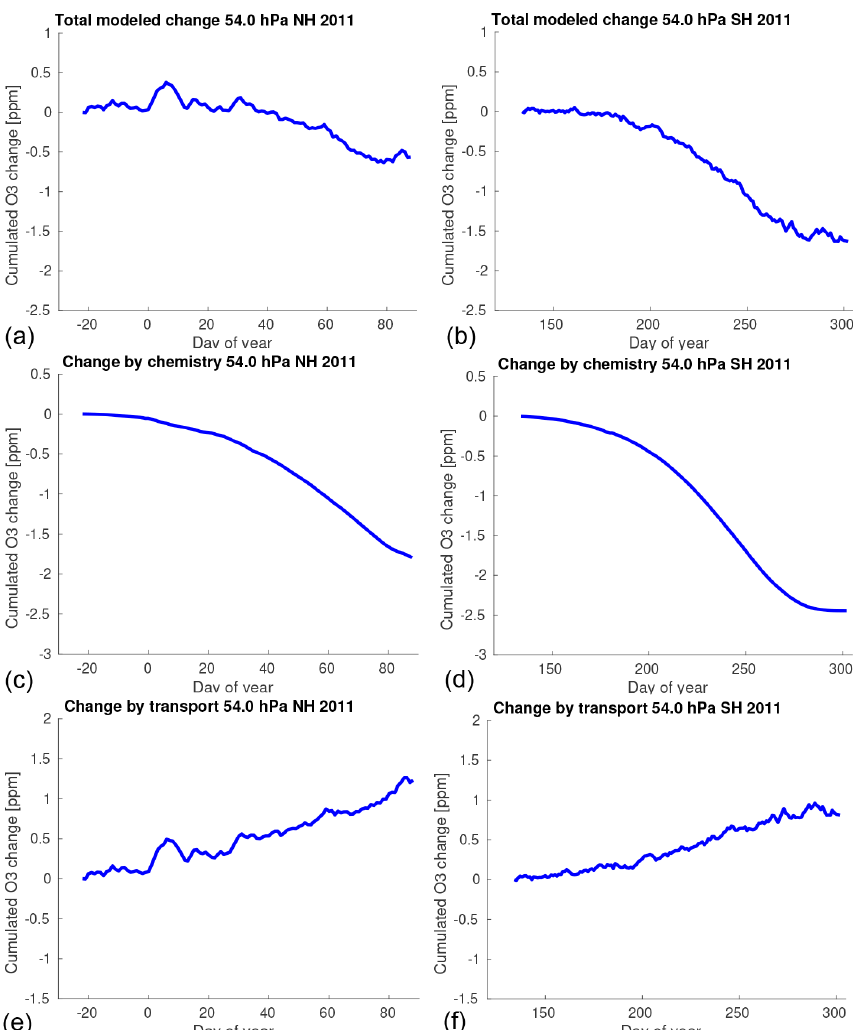
Figure 1. Cumulated change of vortex-averaged ozone mixing ratio for the Northern Hemisphere winter 2010/2011 (a, c, e) and the Southern Hemisphere winter 2011 (b, d, f) at 54hPa simulated by ATLAS–SWIFT as a function of the day of year. Panels (a) and (b) show the total simulated change, panels (c) and (d) show the change by chemistry and panels (e) and (f) show the change by transport.